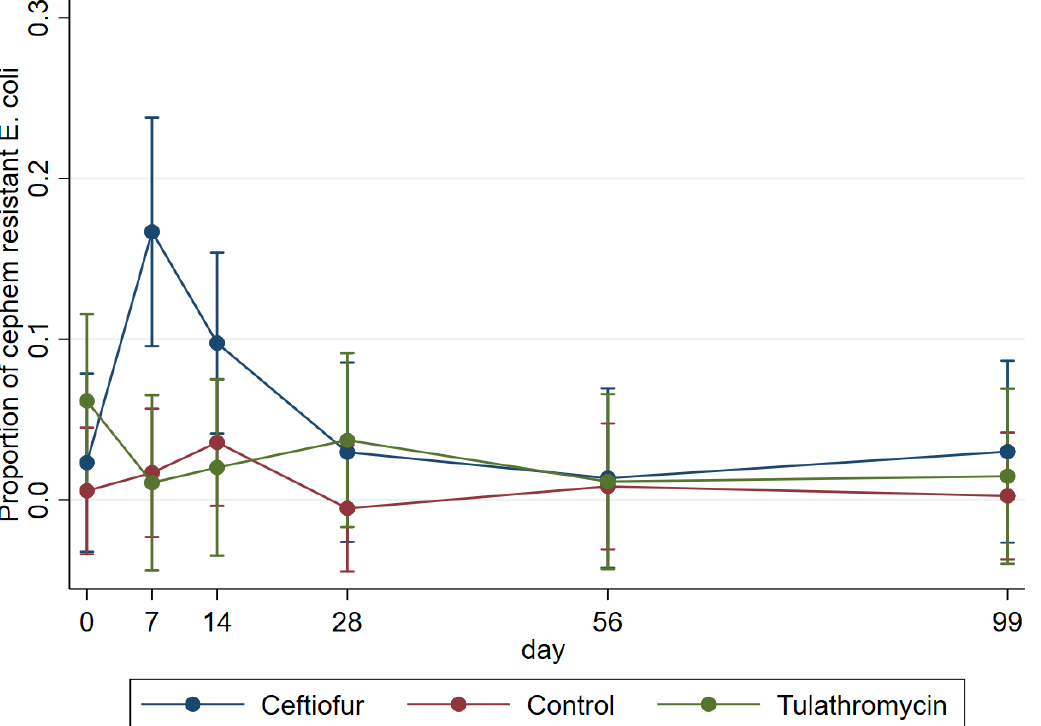
Figure 1. Modeled marginal linear predictions of treatment effects on total Log 10 CFU E. coli recovered from fecal samples before (Day 0) and after (Days 7–99) treatment.